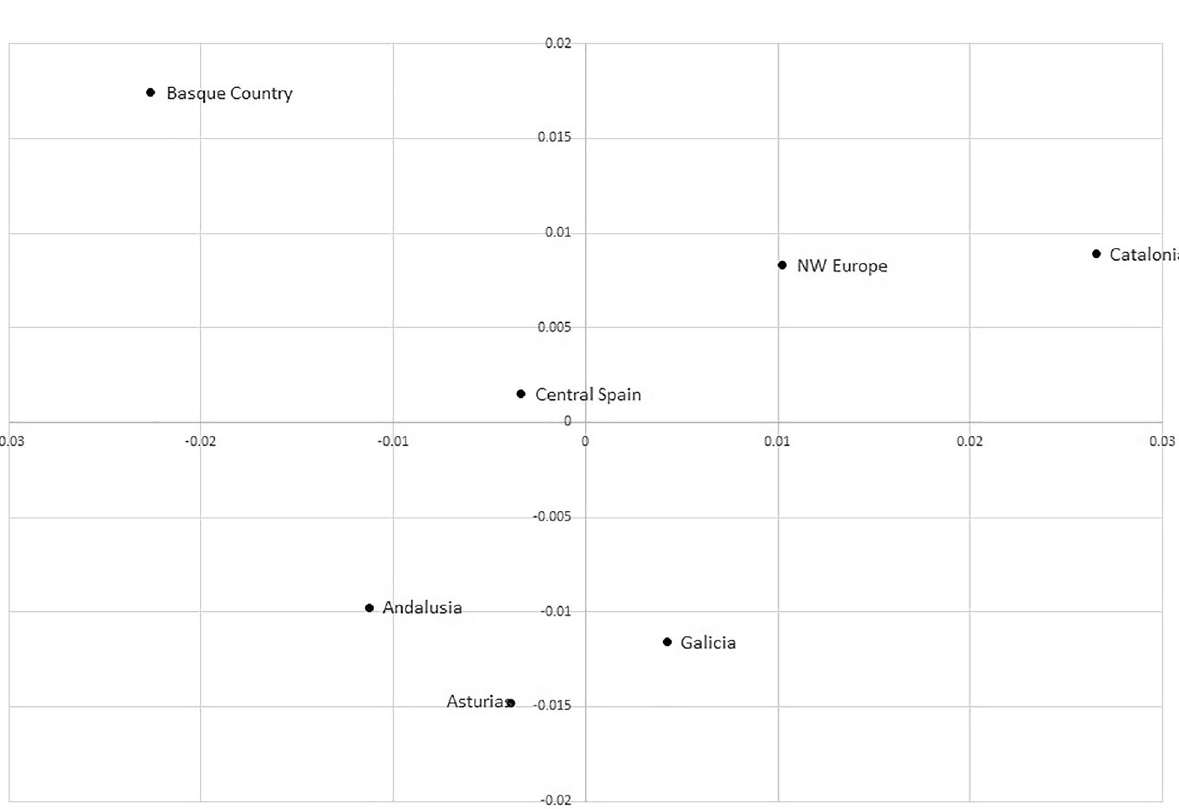
Figure 3. MDS plot of the φst distance among geographical regions. Stress was